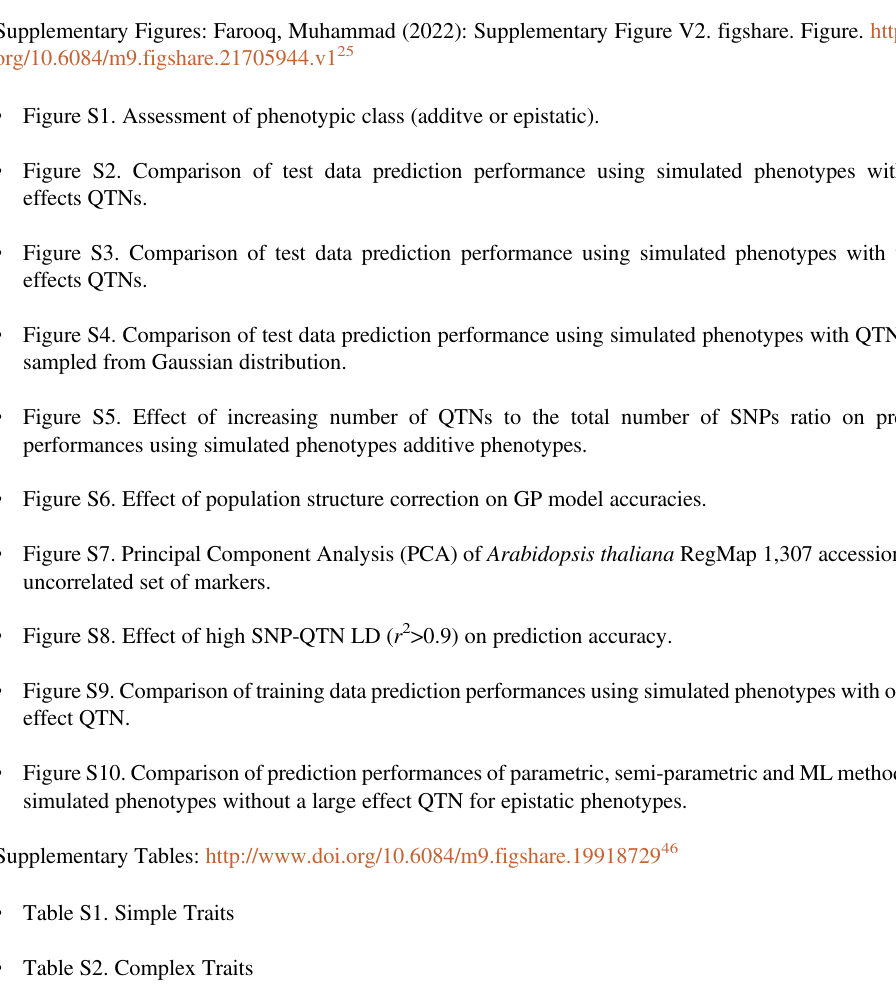
Figshare: Extended data for ‘ Genomic prediction in plants: opportunities for ensemble machine learning based approaches ’ .